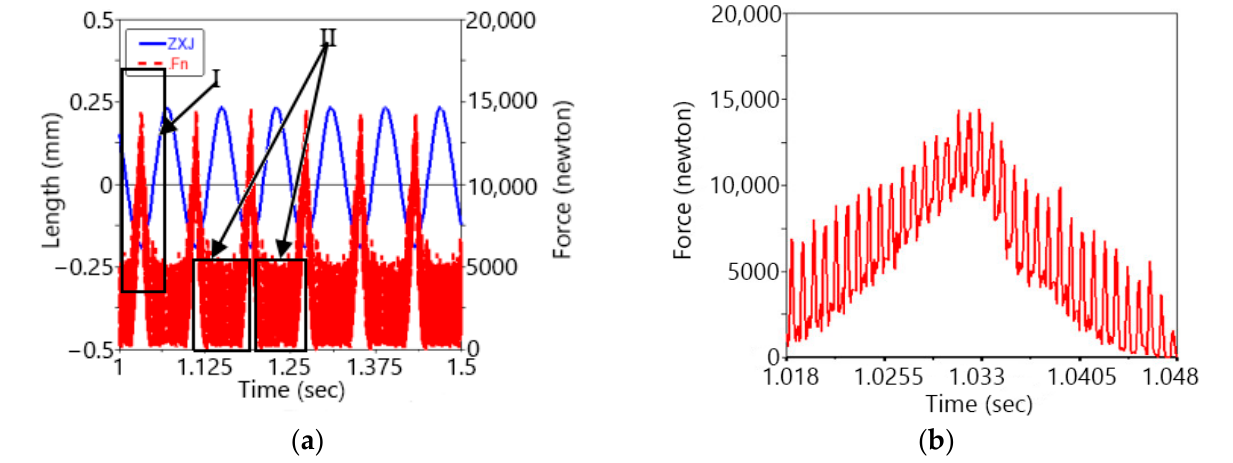
Figure 6. Fault-free condition: ( a ) relationship between meshing force and center distance fluctuation; ( b ) zoom magnified image of position Ⅰ .